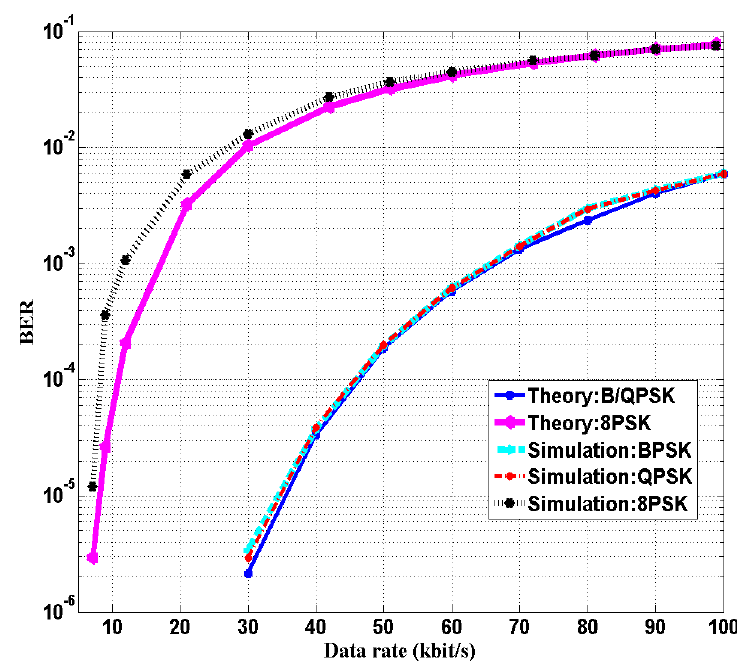
Figure 8. Performance of BPSK, QPSK and 8PSK versus data rate in simulation and theory at S = 11 cm.